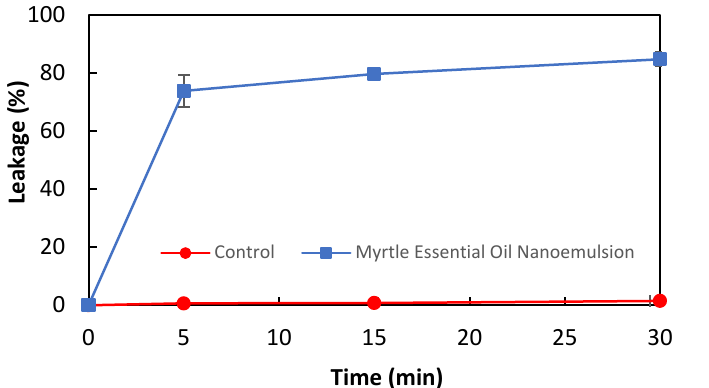
Figure 1. The effect of myrtle essential oil nanoemulsion on the leakage of nucleic acids of L. monocytogenes cells.